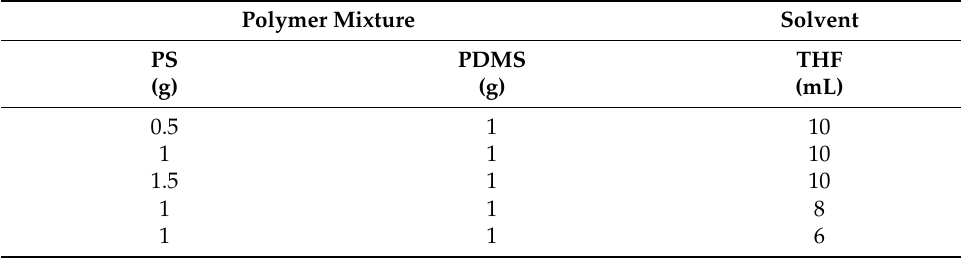
Figure 1. SEM images of: ( a ) neat PS 10%; PS/PDMS fiber mats produced on Al: ( b ) PS/PDMS/THF— 1:1:8 (g/g/mL), ( c ) PS/PDMS/THF—1:1:10 (g/g/mL), ( d ) PS/PDMS—0.5:1:10 (g/g/mL), and ( e ) PS/PDMS—1.5:1:10 (g/g/mL). The scale bar is equal to 30 µm. Table 1. Parameters/conditions for preparation/electrospinning of PS/PDMS.